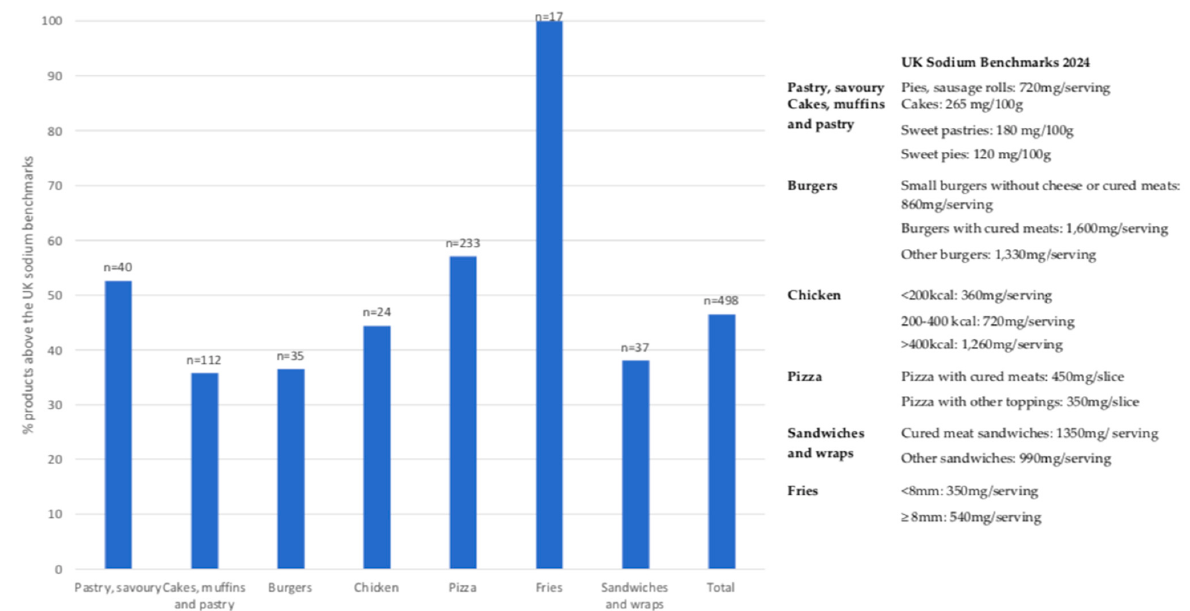
Figure 2. Proportions of products above the 2024 UK sodium targets for the respective food category.